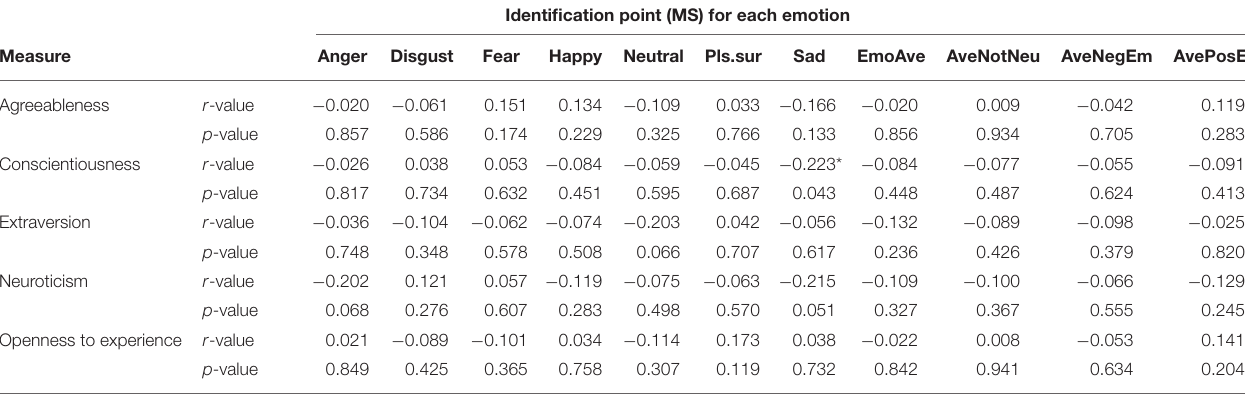
TABLE 7 | Pearson’s correlations ( R -Value) and their significance level (* P < 0.05) between identification point in ms and the Big Five Inventory (BFI). Identification point (MS) for each emotion Measure Anger Disgust Fear Happy Neutral